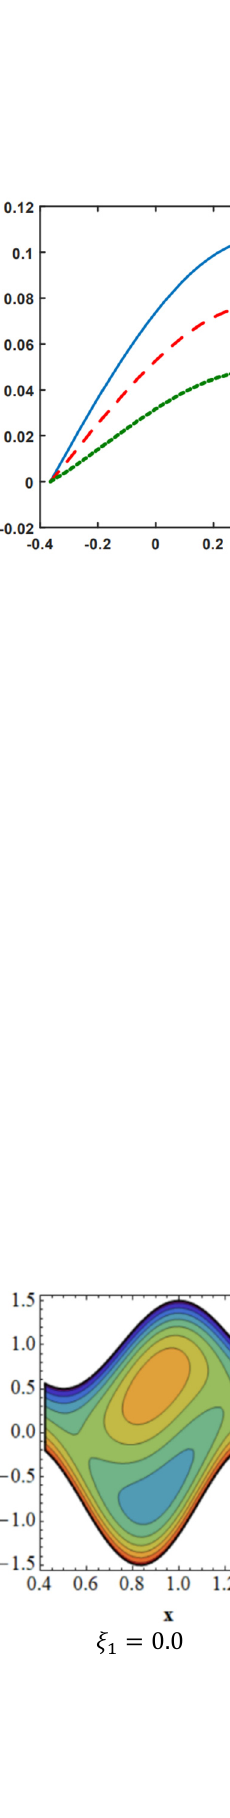
Figure 6. (a–c) Impact of 𝜉 (cid:2872) , 𝑅𝑑 , 𝑁 (cid:3029) , 𝐵𝑟, and 𝑁 (cid:3021)(cid:3004) on nanoparticle fraction.